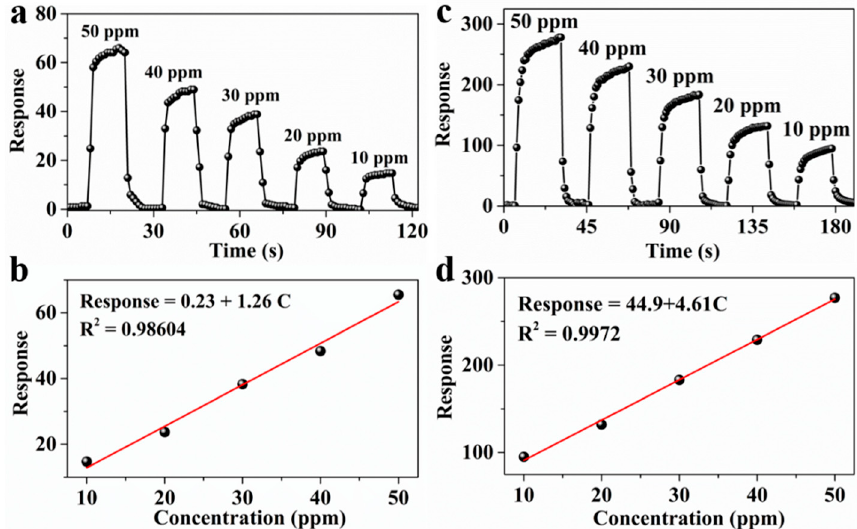
Figure 5. ( a ) Relation between responses of p-PANI/CNT and NO 2 concentrations, ( b ) the fitting plots of responses Vs NO 2 concentration, ( c ) Relation between responses of n-PANI/CNT and NH 3 concentrations, ( d ) the fitting plots of responses Vs NH 3 concentration.